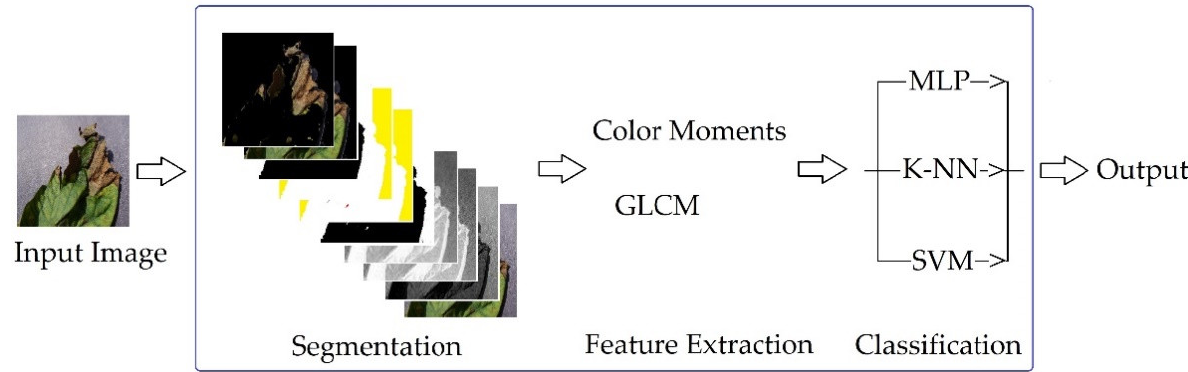
Figure 7. Architecture of the proposed model.